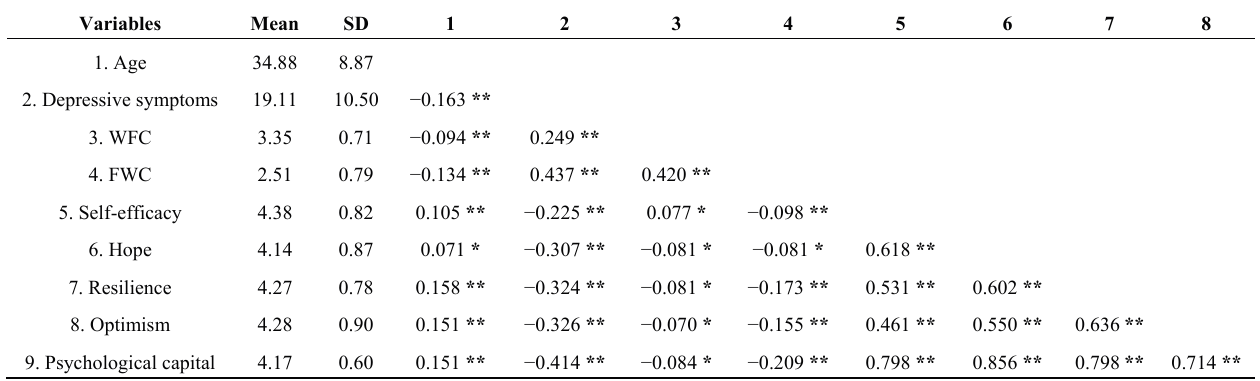
Table 3. Means, standard deviations (SD) and correlations of continuous